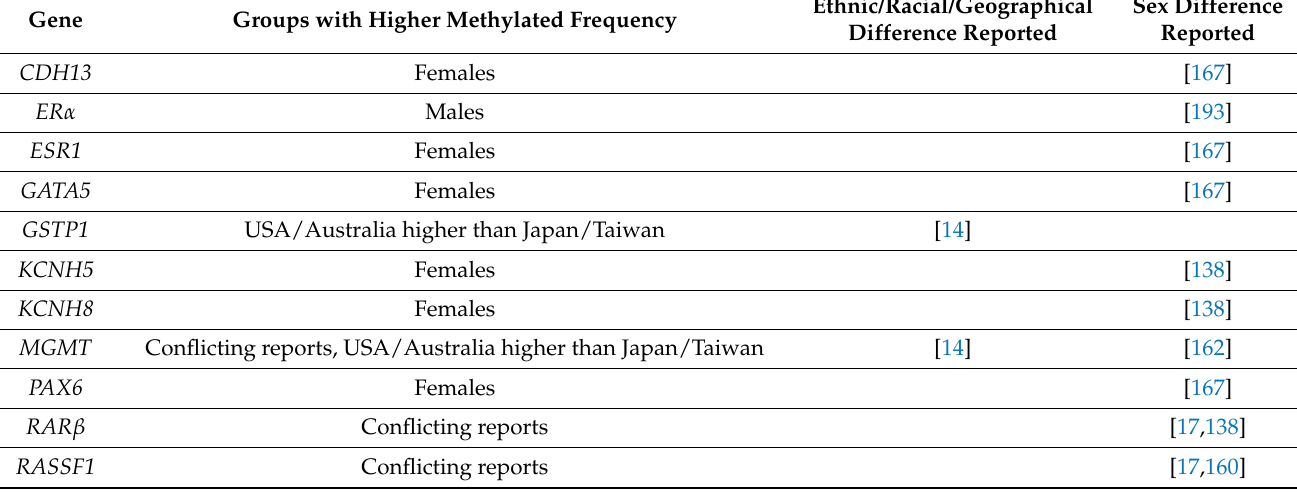
Table 2. Selected aberrantly methylated genes in lung cancer with reported gender and or ethnicity